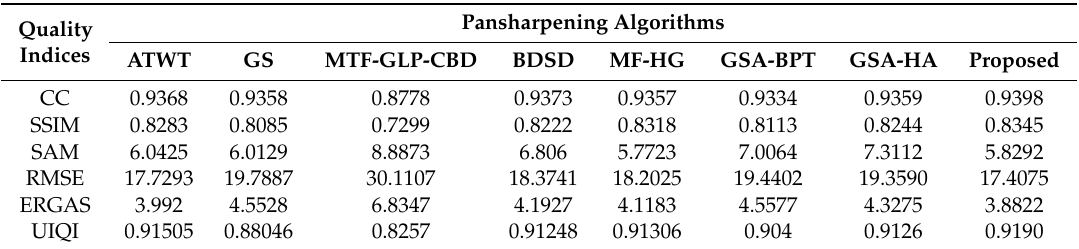
Table 3. Objective quantitative indices obtained by compared methods for degraded QuickBird data set.